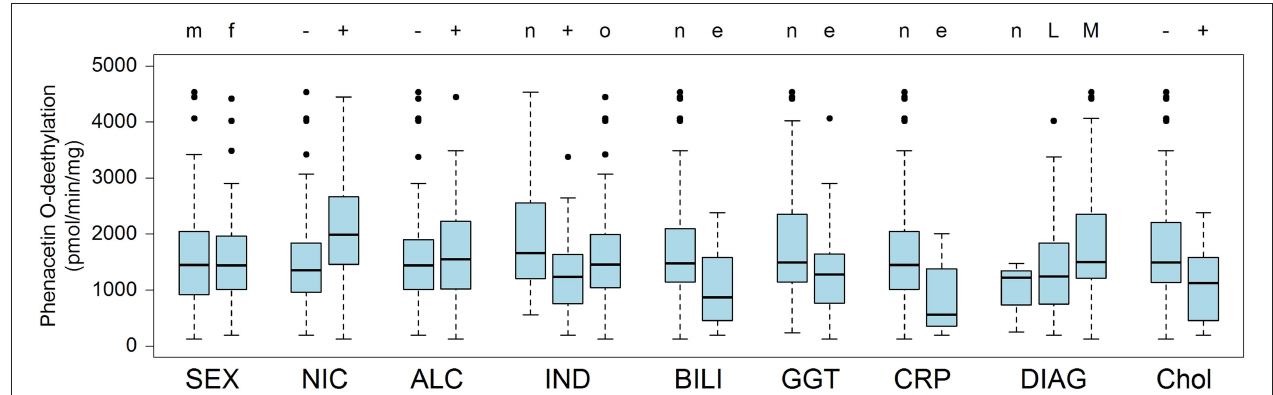
(n) value in normal range, (e) elevated value; DIAG, diagnosis leading to liver resection, (n) no tumor, (L) primary liver tumor, (M) metastasis of other primary tumor; Chol, cholestasis, ( − ): non-cholestatic, ( + ) cholestatic. For results on mRNA and protein and for statistical information see Table 3 . Boxes are defined by the 25 and 75% quantile. The median is displayed as vertical line inside of the box. Whiskers are defined as the lowest/highest data point still within 75%/25% quantile ± 1.5 times the interquantile range (75–25% quantile). Outliers are shown as